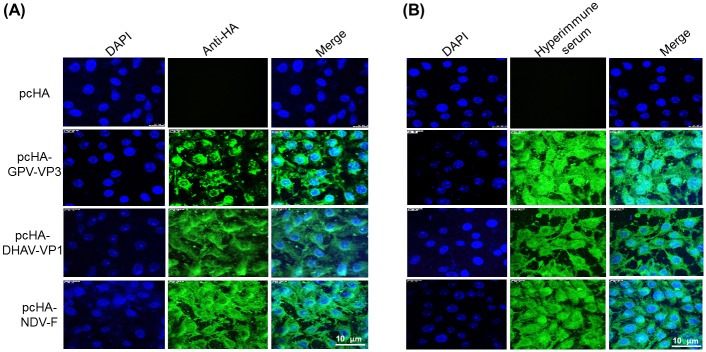
Analysis of exogenous genes expression in the GEE cell line by IFA.The GEE cell line was mock-transfected with pcHA or transfected with either pcHA_GPV-VP3, pcHA_DHAV-VP1 or pcHA_NDV-F. At 48 post transfection, cells were fixed with 2% paraformaldehyde for 15 min and permeabilized with 0.5% Triton X-100 in PBS for 5 min. Monoclonal anti-HA antibody and hyperimmune serum from injected chicken with respective viruses were used as a primary antibody in (panel; A) and (panel; B), respectively. While Alexa Fluor® 488 (Green staining; Santa Cruz Biotech) and anti-chicken IgY (IgG) (whole molecule)—FITC antibody produced in rabbit were used as secondary antibodies. Nuclei were stained with DAPI (Vector Laboratories).